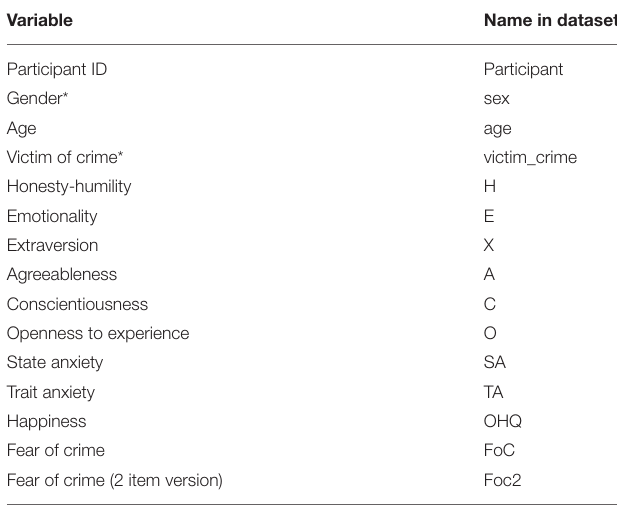
TABLE 1 | Information about the included dataset— data.csv (Supplementary